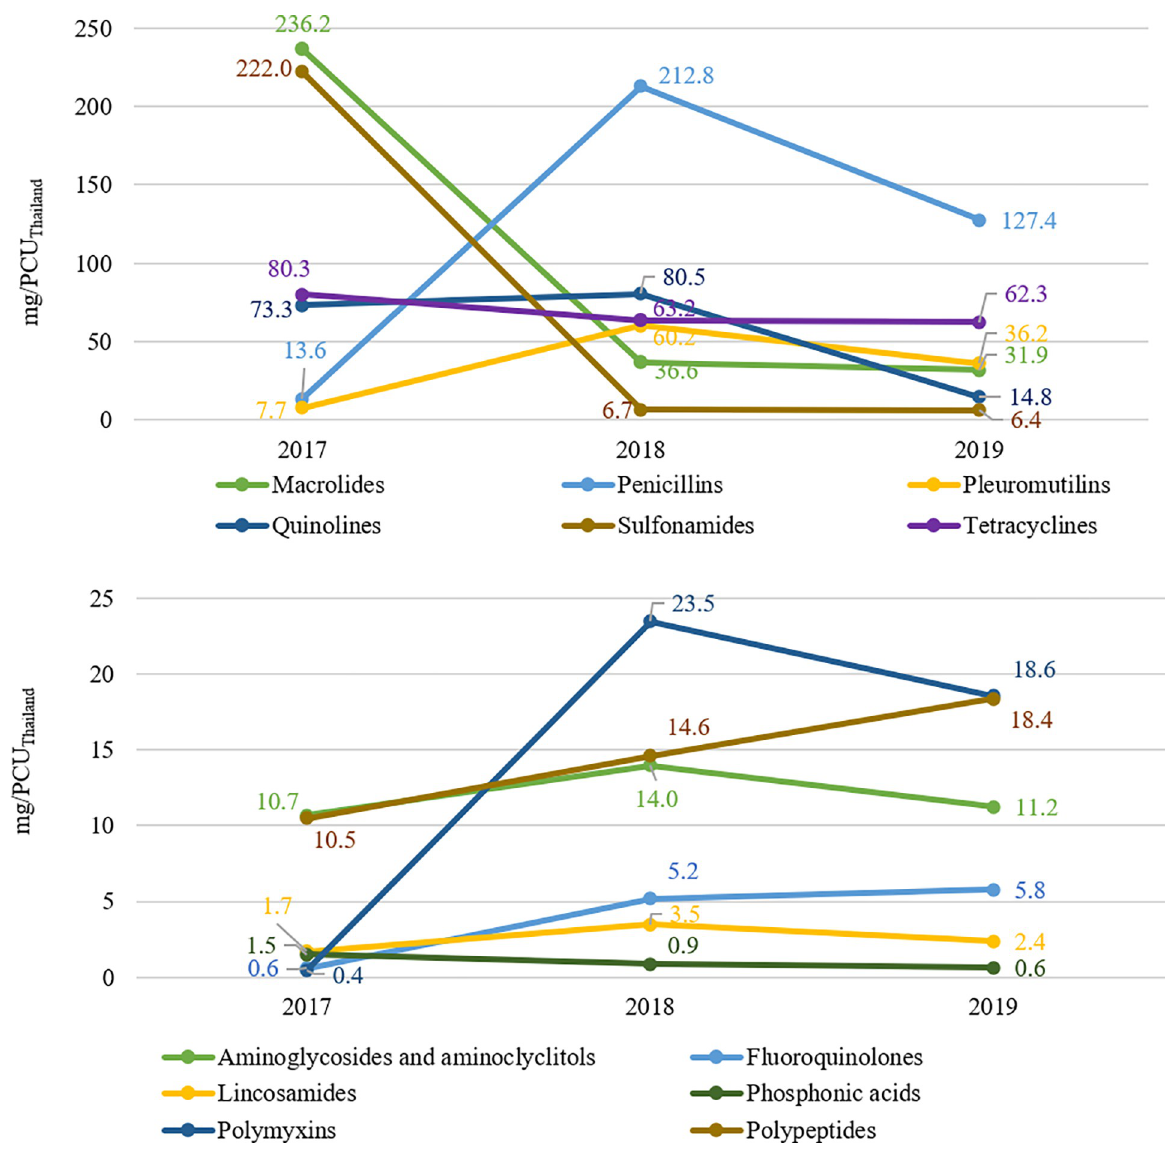
Fig 1. Amount of antimicrobial consumption in food producing animals by antimicrobial class (2017–2019) (mg/PCU Thailand ). (top) Antimicrobials with > 50 mg/PCU Thailand in at least a year between 2017 and 2019. (bottom) Antimicrobials with < 50 mg/PCU Thailand between 2017 and 2019 (not included amphenicols, cephalosporins, orthosomycins, phosphoglycolipids).